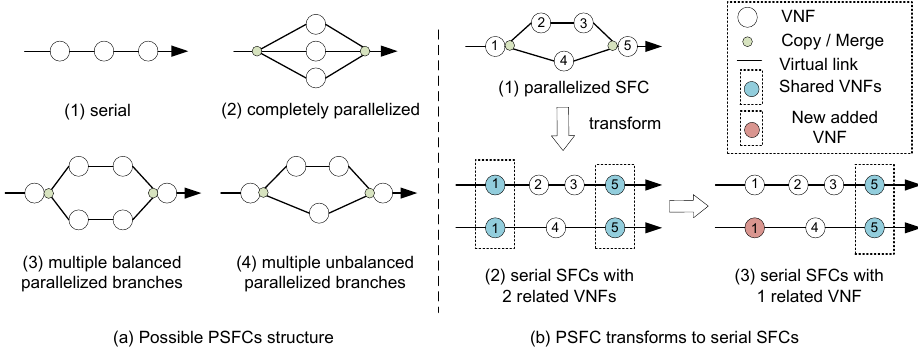
Figure 3. Possible PSG structures and PSFC